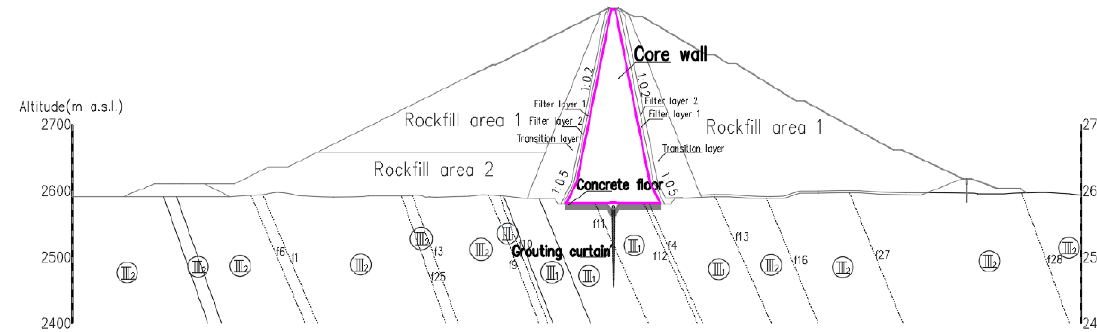
Figure 19. The dam body cross-section.